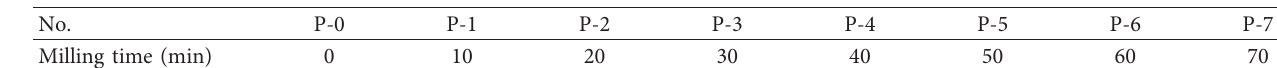
Table 2: Experimental design.